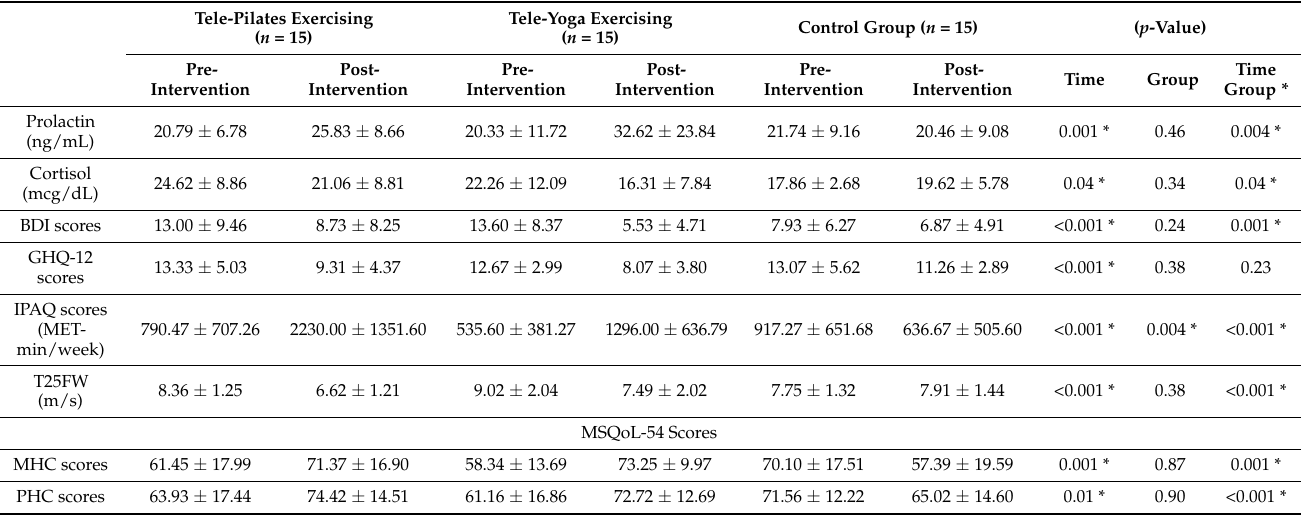
Table 2. Effects of 8 weeks of tele-exercising in measurement scores.